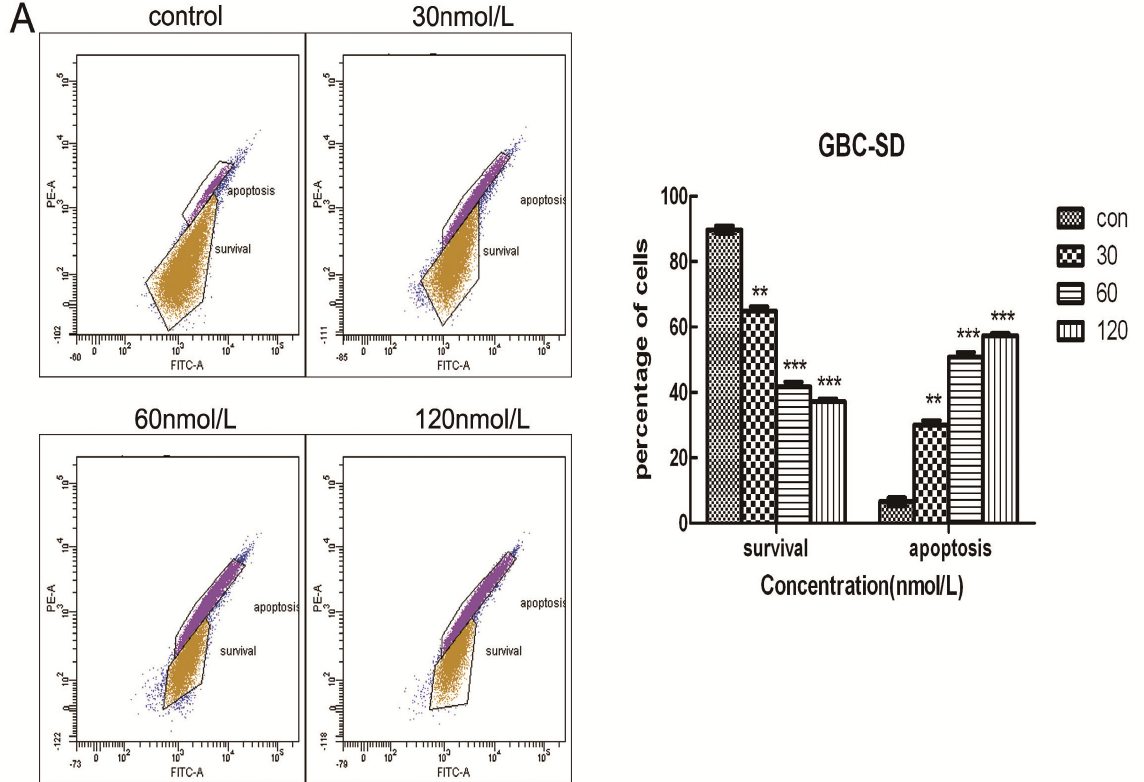
Figure 5. Triptolide decreases mitochondrial membrane potential ( ΔΨ m) in gallbladder cancer cells. ( A ) and ( B ), Flow cytometric analysis of ΔΨ m. GBC-SD and SGC-996 cells were treated with triptolide followed by rhodamine 123 staining. Cells with high ΔΨ m are marked “survival” and those with low ΔΨ m are marked “apoptosis.” Percentage (%) of cells with high ΔΨ m (survival) and low ΔΨ m (apoptosis) are shown ( A and B , right panel). Values represent the mean ± SD ( n = 3). * p < 0.05; ** p < 0.01; *** p <